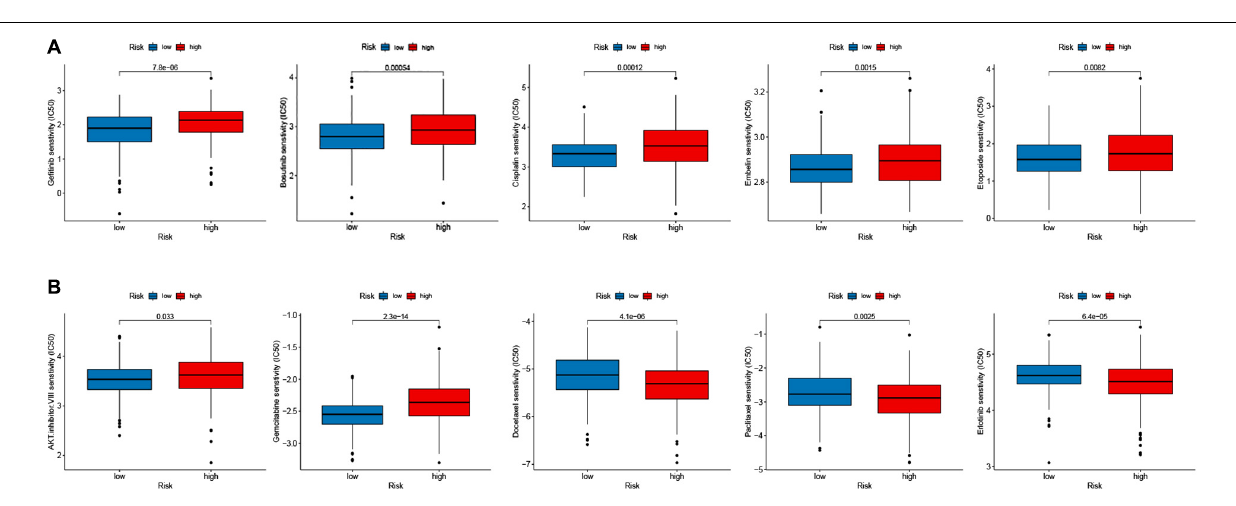
The AUCs of the nomogram at 3- and 5-year survival times were 0.739 and 0.728, respectively ( Figure 8B ). We used the calibration curve to show the prediction value of the nomogram,